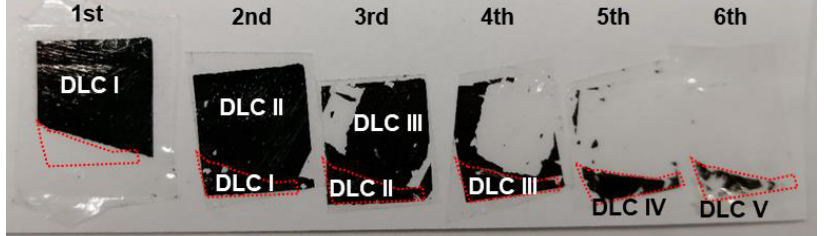
Figure 13. Appearance on the tapes of the 11-layer films after peeling.